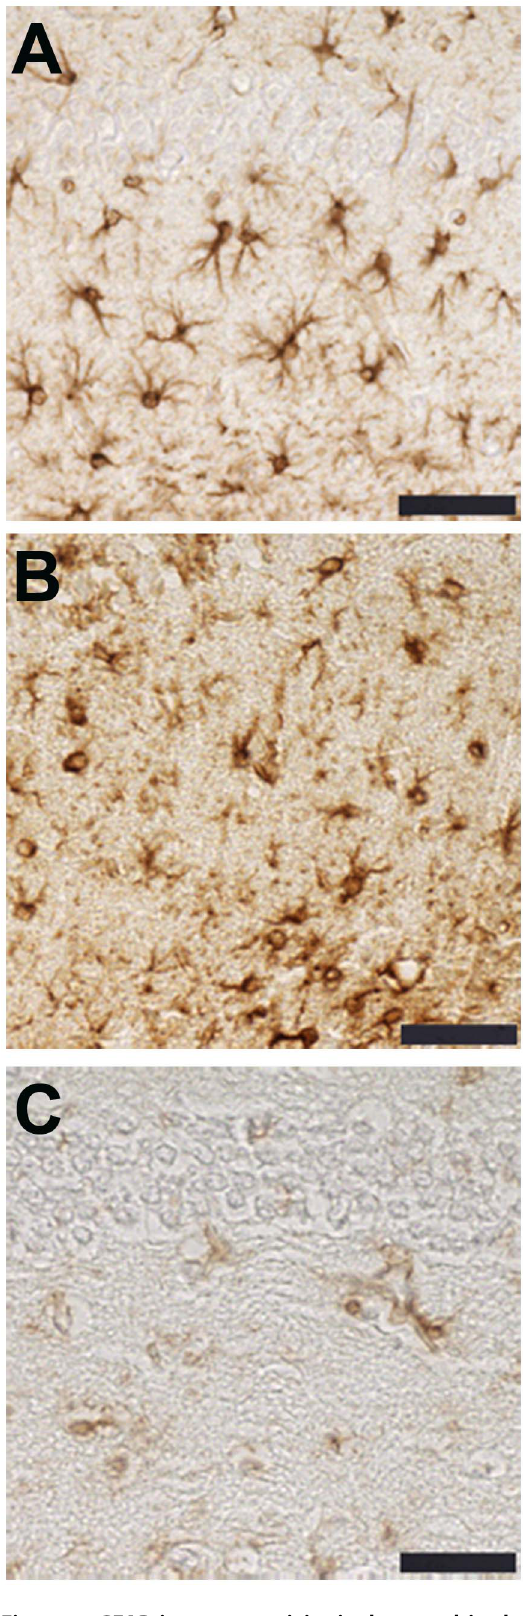
Figure 4. GFAP immunoreactivity is decreased in the hippo- campus (CA1 stratum radiatum) of CCI mice treated with hydrogen water. Representative images demonstrate similar levels